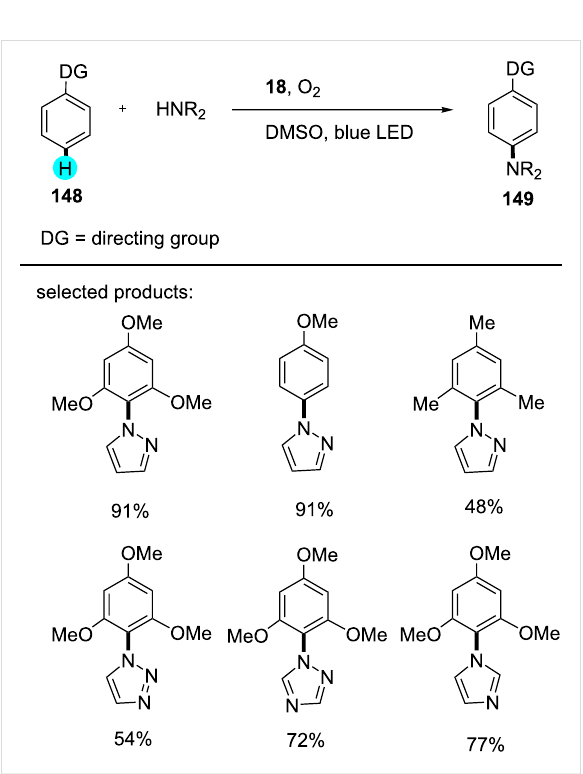
Scheme 27: Aerobic aminations with semiconductor photoredox cata- lyst 18